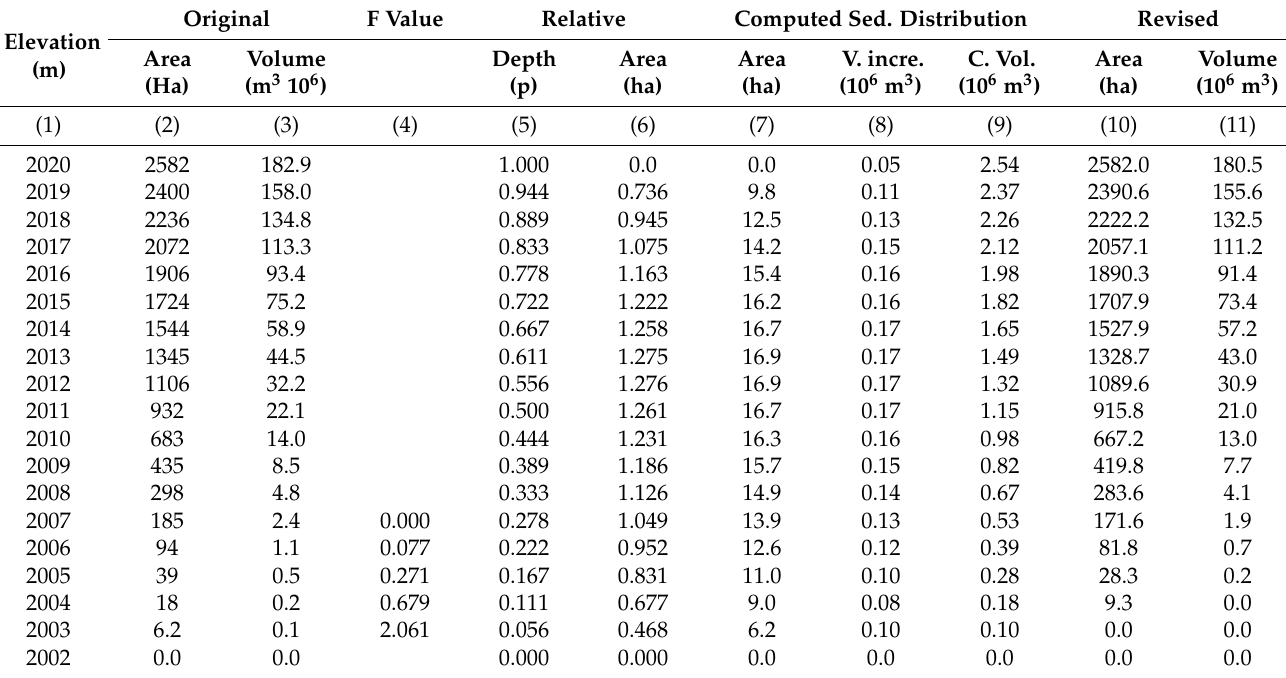
Table 6. Empirical area reduction method; computation of sediment distribution at Koga